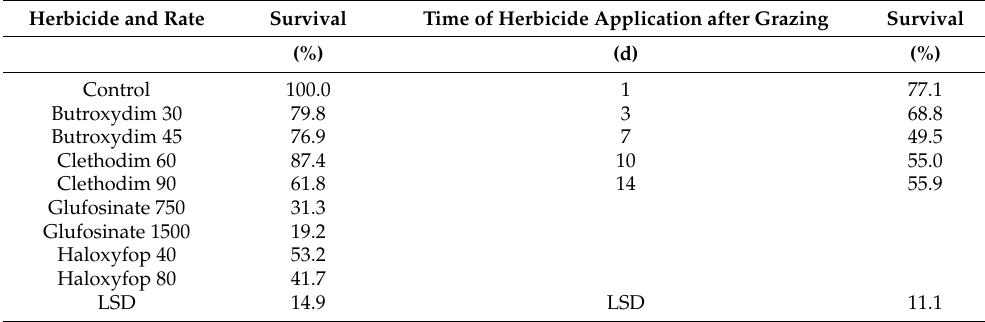
Table 2. The effect of herbicide treatment and their application timing (1, 3, 7, 10, and 14 d after grazing) on the survival (%) of Chloris virgata